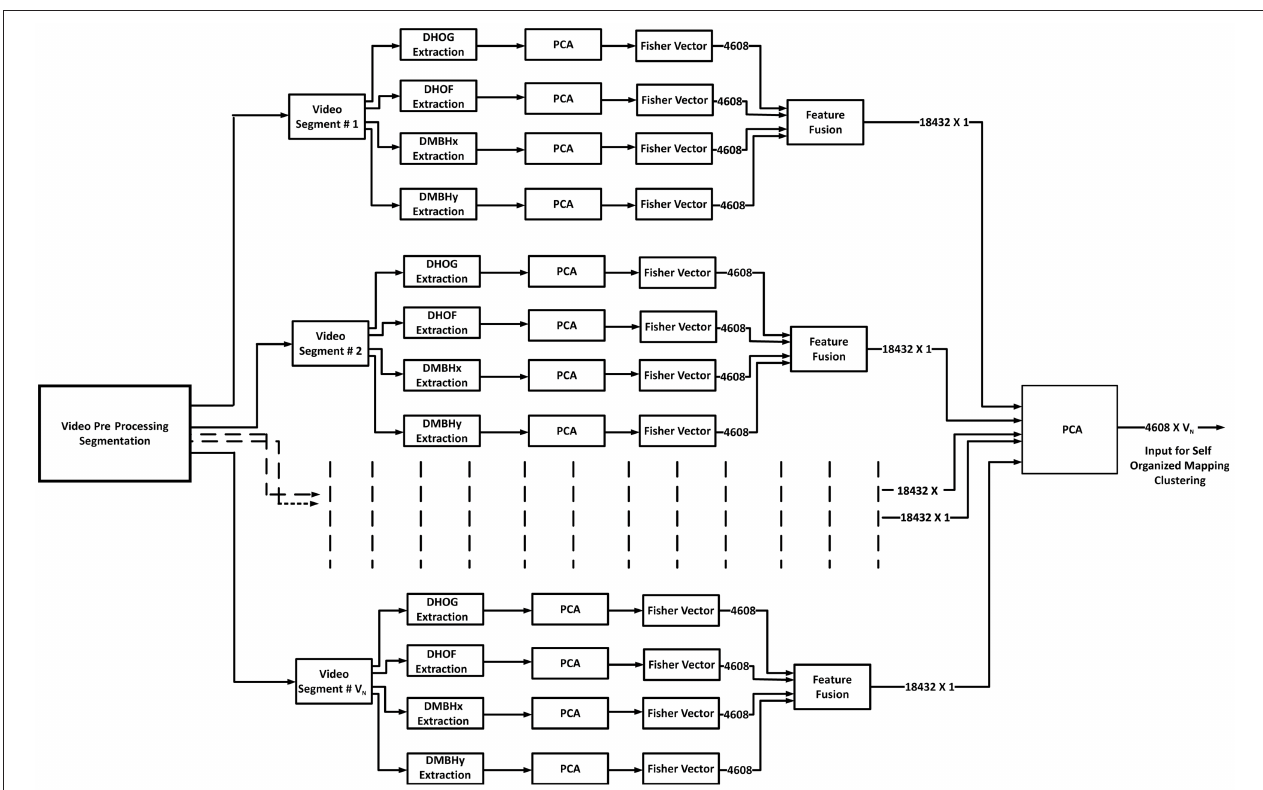
FIGURE 5 | Visual feature fusion: where V N is the total number of video segments ( V N = 58,541) in the MLA dataset.